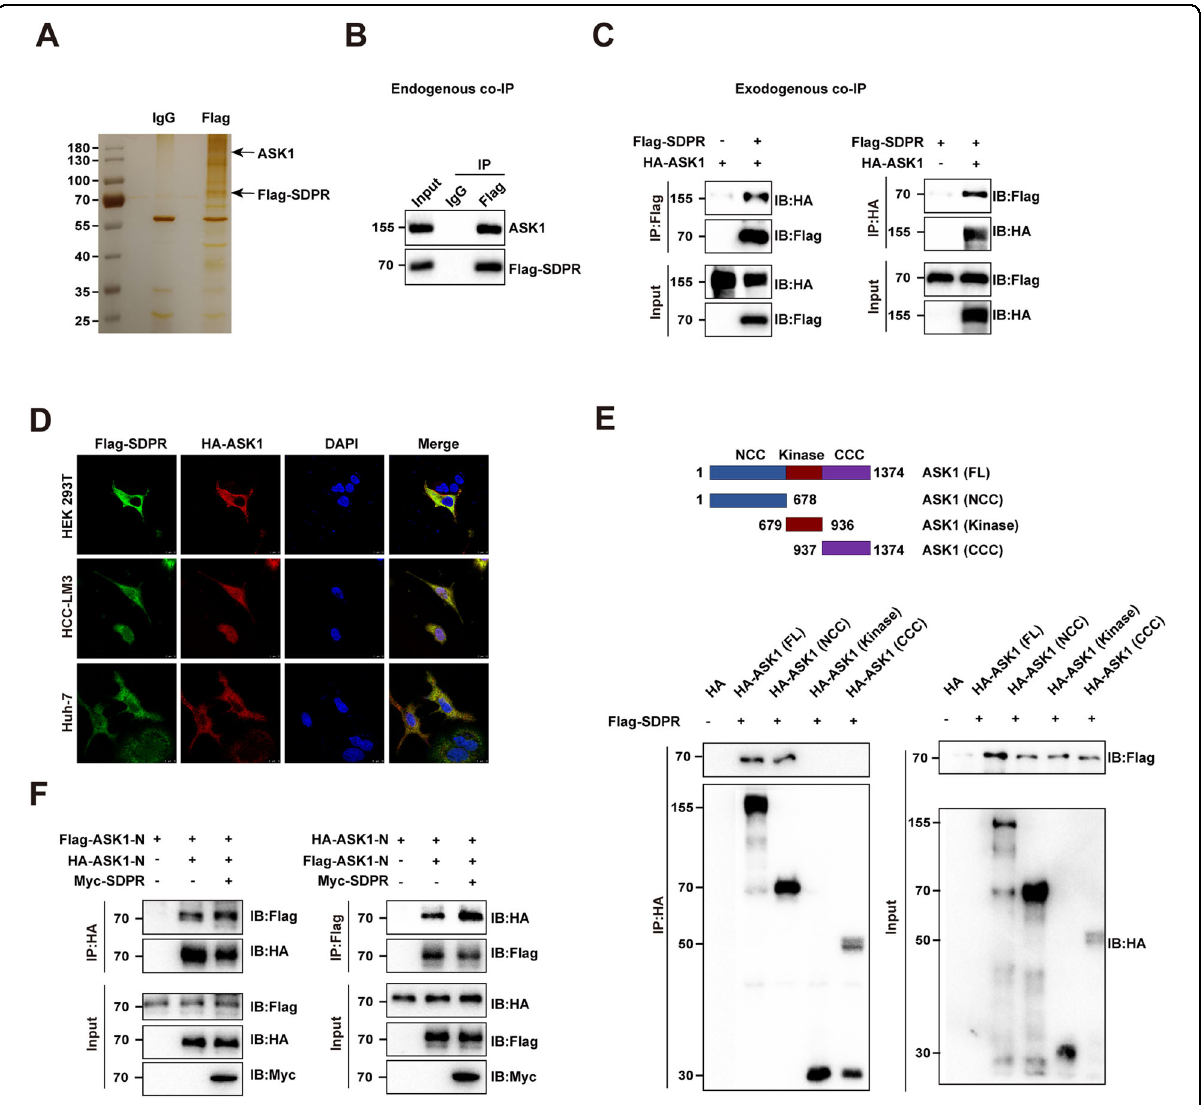
Fig. 5 SDPR interacted with and activated ASK1. A SDPR-binding proteins were presented by immunoblotting and silver staining. B , C Endogenous co-IP assay and exogenous co-IP assays were conducted to fi nd the interaction of SDPR and ASK1. D Immuno fl uorescence analysis showed SDPR and ASK1 co-located after co-transfected with FLAG-SDPR and HA-ASK1 in HEK-293T, HCCLM3, and Huh-7 cells. E HA-tagged full- length and three truncated mutants ((1) N-terminal, HA-ASK1 1-678 , (2) Kinase, HA-ASK1 679-936 , and (3) C-terminal, HA-ASK1 937 – 1374 ) of ASK1 were cotransfected with FLAG-SDPR in HEK 293T cells and then lysates were immunoprecipitated by utilizing anti-HA antibody. F HA/FLAG-tagged ASK1 N-terminal and MYC-tagged SDPR were cotransfected into HEK 293T and immunoprecipitated using anti-HA/FLAG antibodies to detect ASK1 N- terminus dimerization. * p < 0.05; *** p < 0.01; *** p <